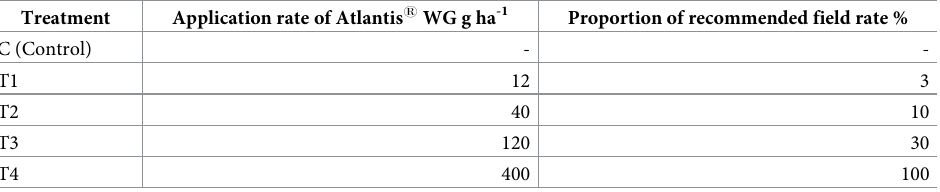
Table 2. Treatments with the test substance Atlantis 1 WG.